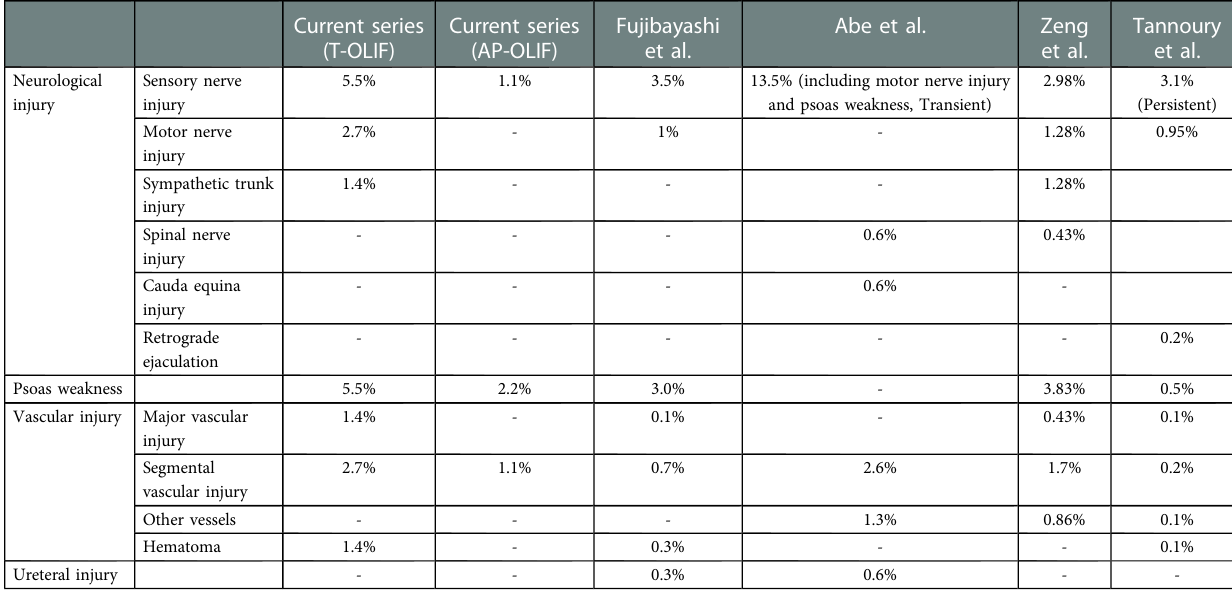
TABLE 2 Comparison of approach related complications rate of current series with other reports.